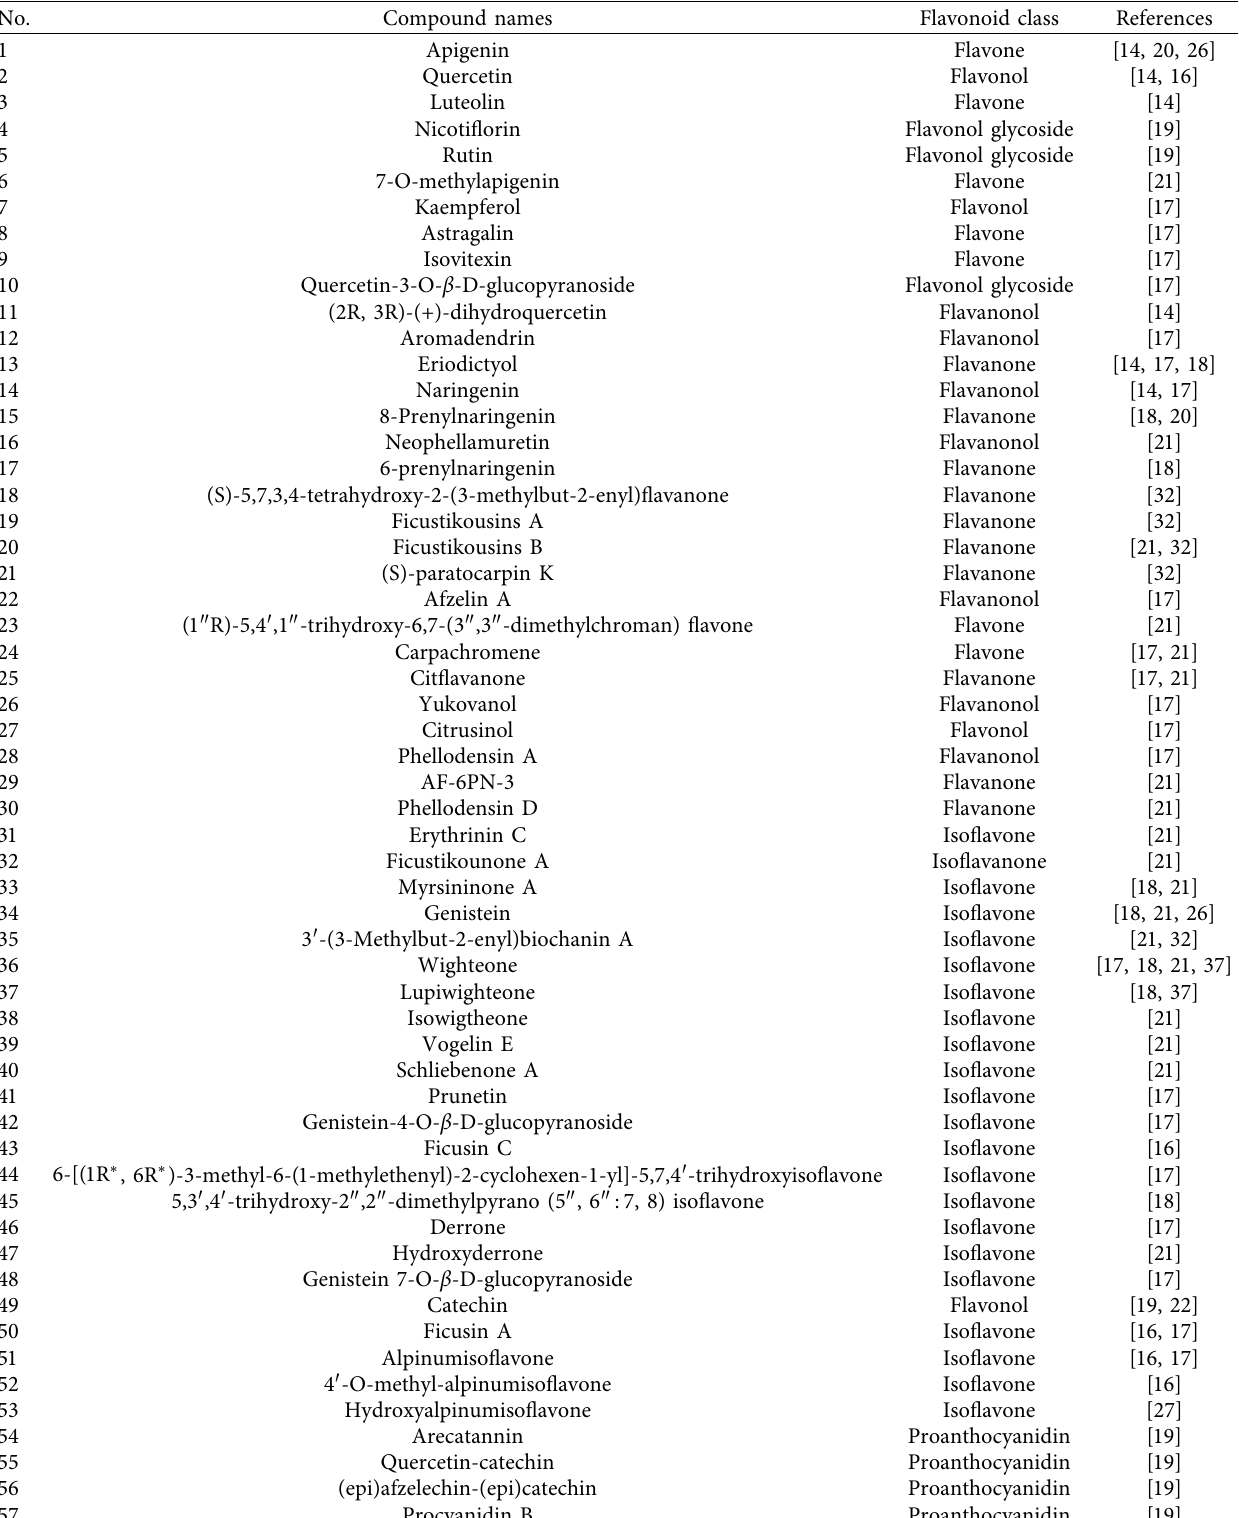
Table 1: Flavonoids and lignans isolated from F. tikoua